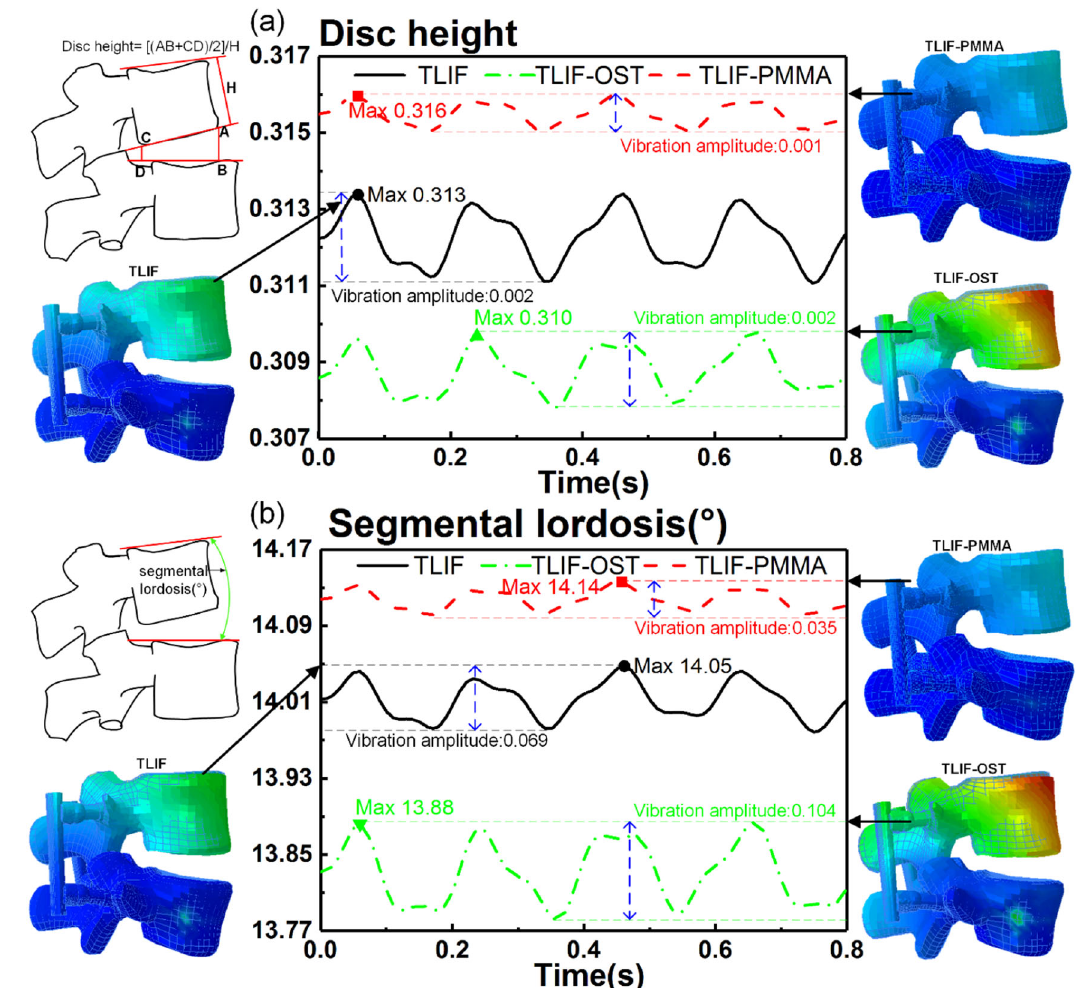
Fig. 7 The dynamic response of a disc height and b segmental lordosis at L4-L5 fused level for TLIF, TLIF-OST and TLIF-PMMA models. Segmental lordosis: the angle represented by green